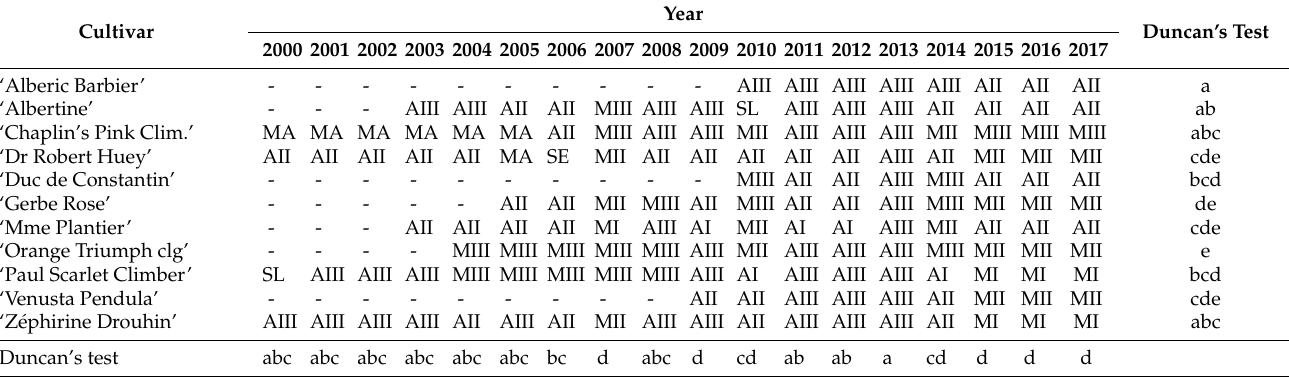
Note: Means with the same letter are not significantly different between cultivars (vertically) and years (horizon- tally) at p ≤ 0.05 in Duncan’s range test. Table 6. Time frame when the first light green and/or bronze leaves pair develops, not yet at full size (BBCH 11) on unpruned shoots of climber roses; where MI—1–10 March; MII—11–20 March; MIII—21–31 March; AI—1–10 April; AII—11–20 April; AIII—21–30 April; M—after 30